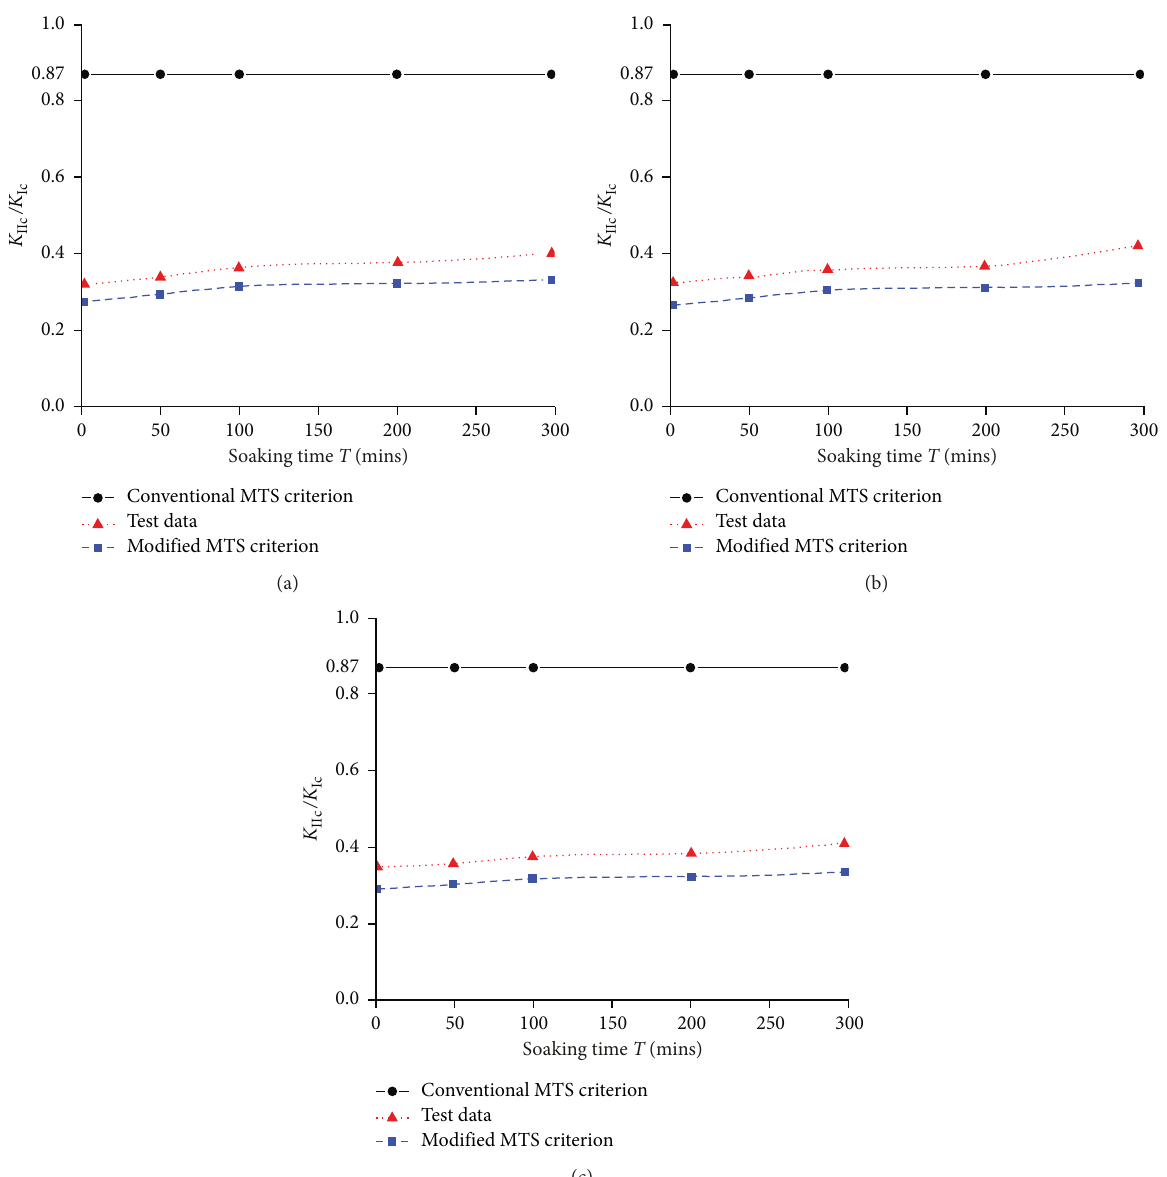
Figure 9: Comparison of test ratio K IIc / K Ic of three types of the mudstone SCB specimens with theoretical values according to the modified MTS criterion: (a) Type A, (b) Type B, and (c) Type C specimens for soaking 0, 50, 100, 200, and 300